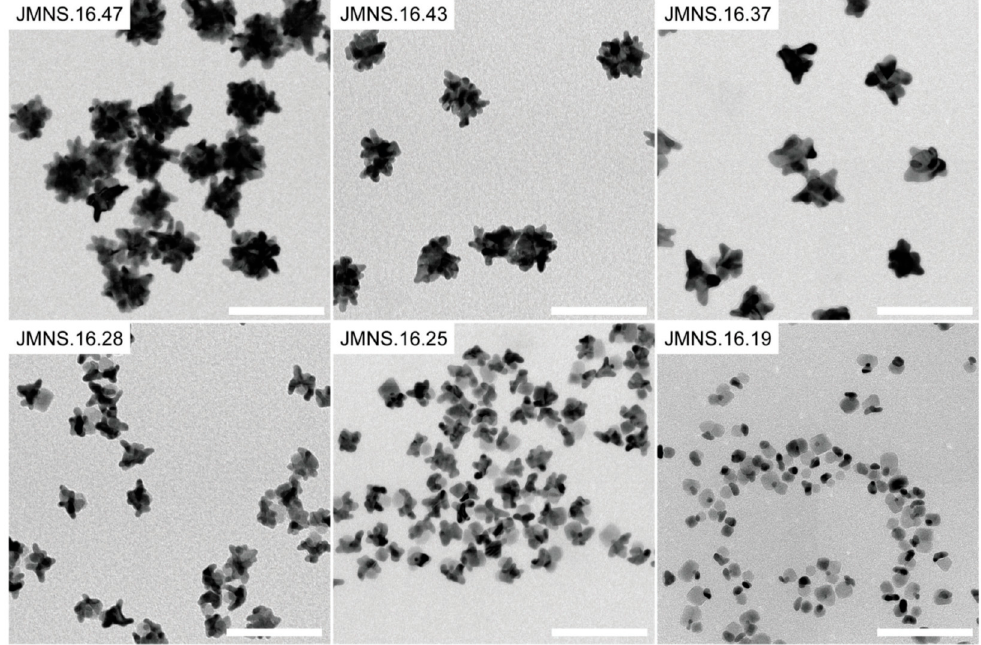
Figure 5. TEM images of the Au-Fe 3 O 4 asymmetric nanostars and dumbbells obtained by varying the ratio of dumbbell seeds to gold salt. Reprinted with permission from [39]. Copyright RSC, 2017.